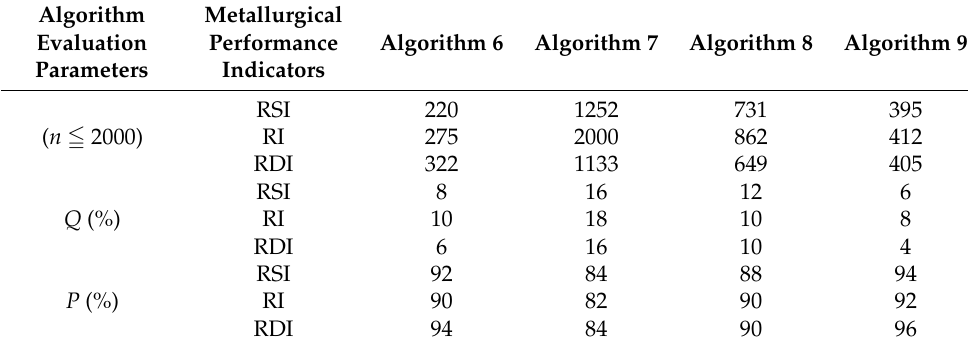
Table 2. Elite sample set for forecast of metallurgical properties of